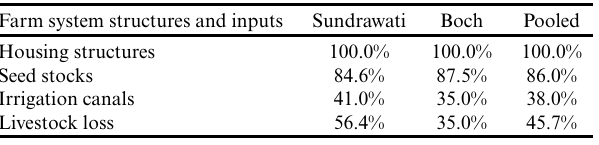
Table 2 . Summary of earthquake impacts to farming systems from survey results in both study communities (n = 79).